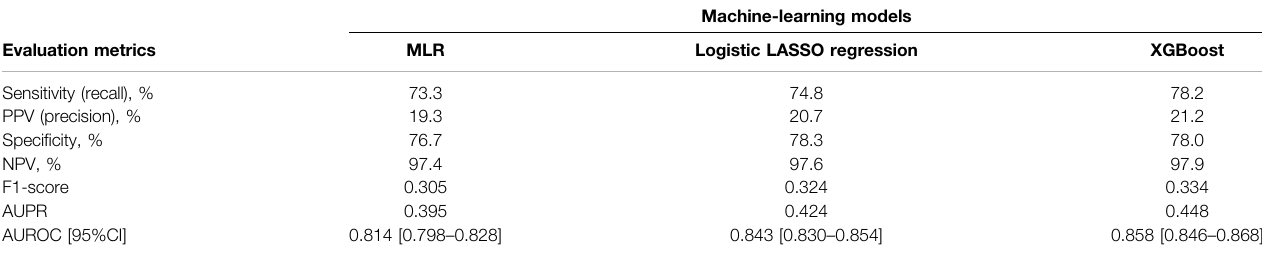
TABLE 3 | Prediction performance of each machine learning